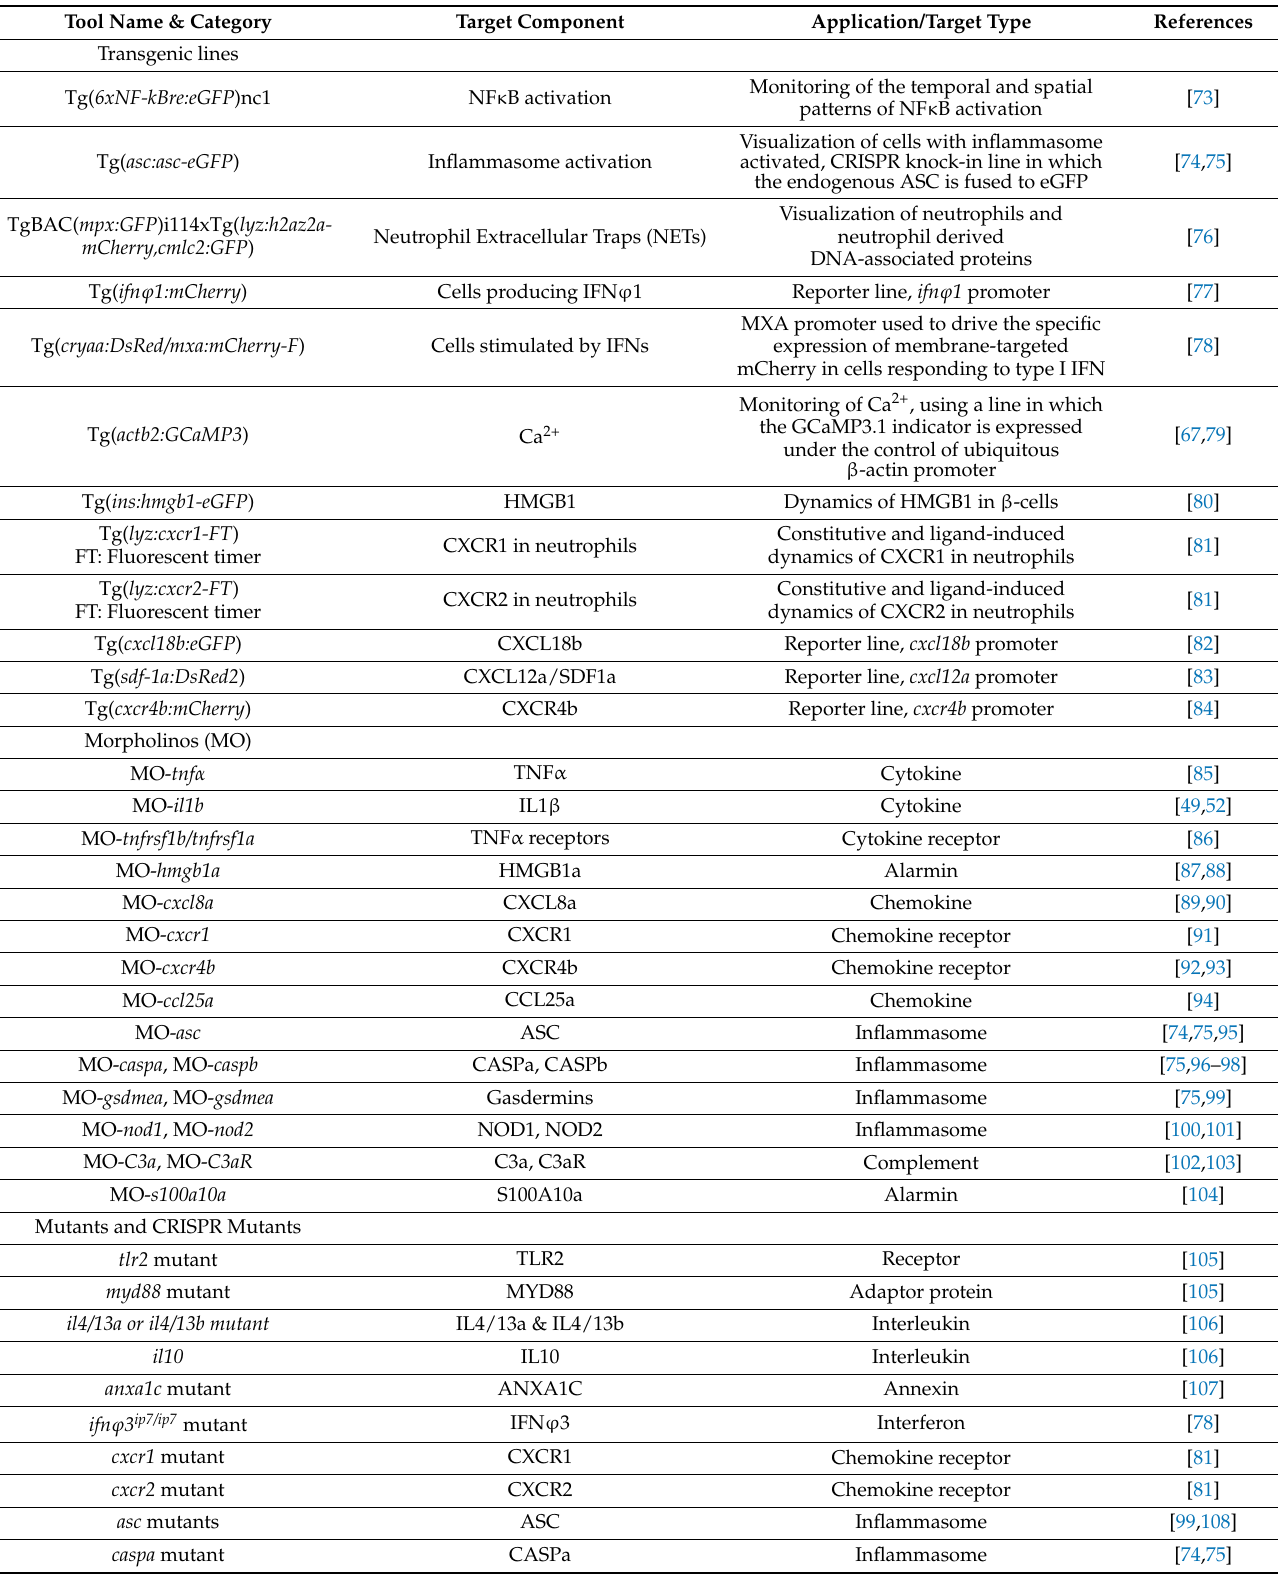
Table 2. Tools generated to study the molecular components of inflammation in zebrafish, including transgenic reporter lines, morpholinos, mutants, recombinant proteins and antibodies, overexpression systems, and fluorescent sensors. Tg: transgenic line; MO: